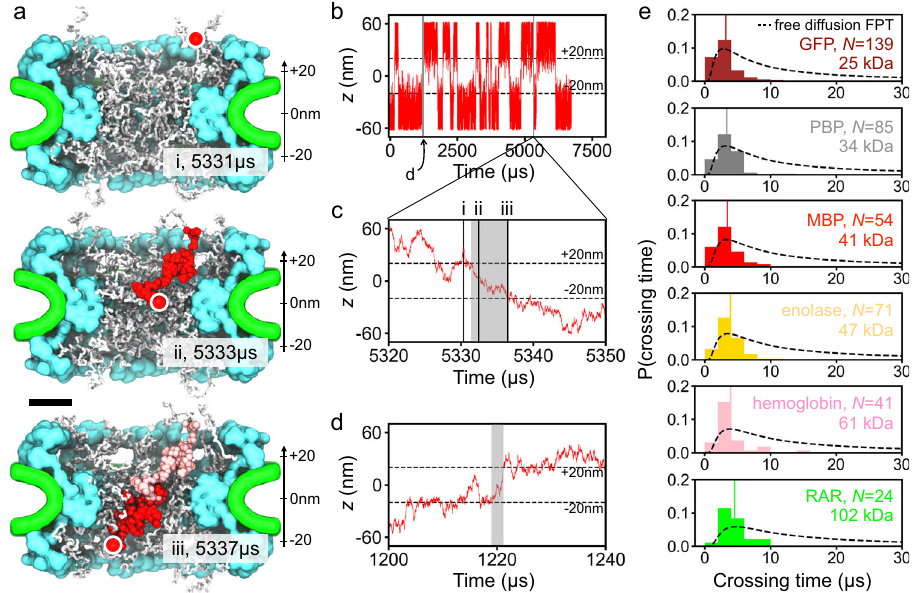
Fig. 3 | Timescale of protein crossings. a Successful translocation of a maltose- bindingprotein(MBP,red)throughtheNPC.Threeinstantaneouscon fi gurationsof the NPC are shown using white for the FG-nups, cyan for the protein scaffold and green for the lipid bilayer. The circle indicates the location of the MBP protein at each con fi guration. Red and pink beads illustrates the con fi gurations explored by the protein betweenthe instantaneous con fi gurations (sampled every25ns).Scale bar, 20nm. b CoM z coordinate of MBP simulated under a 25nm-radius con fi ne- ment potential. Two crossing events form this trace are shown in detail in panels c and d . c Zoomed-in on the crossing event trace. The same event is illustrated by